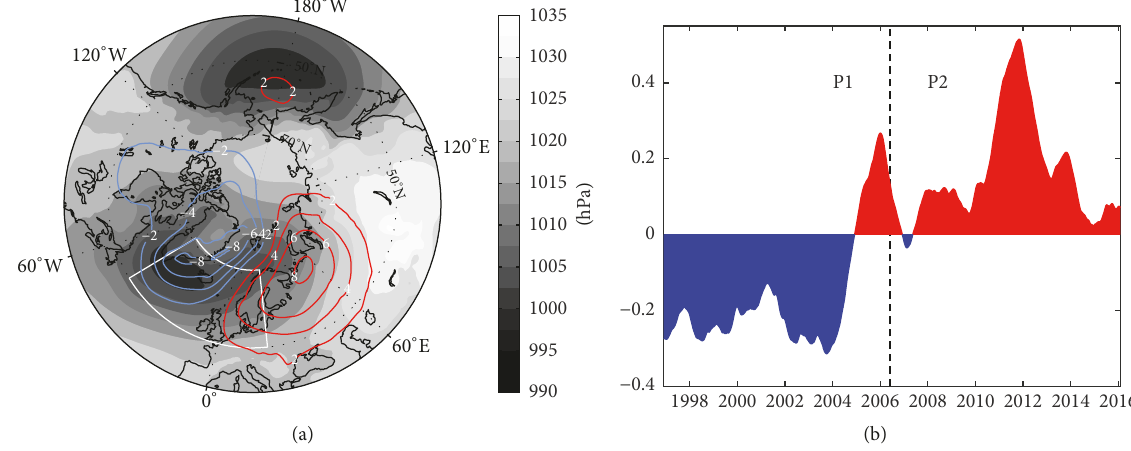
Figure 4: (a) Climatological SLP during DJF 1996–2016 (gray shading) and SLP composite during ATL Box trajectories arriving in Ny- ˚Alesund (hPa, color contours). (b) Normalized time series of the DJF SLP composite pattern shown in (a) with a three-year low pass filter applied (see text for